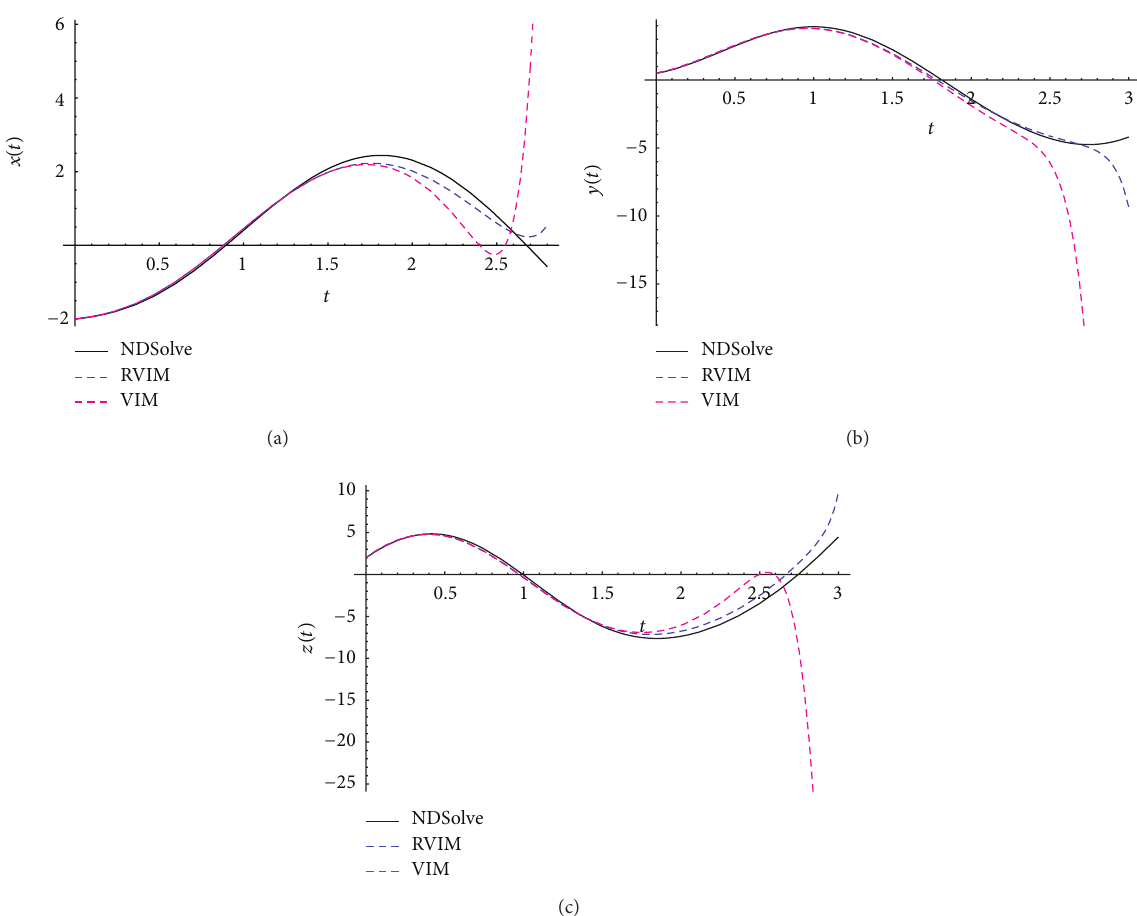
Figure 4: Simulation of the approximate results for 𝛼 1 = 𝛼 2 = 𝛼 3 = .98 and exact results for 𝛼 1 = 𝛼 2 = 𝛼 3 = 1 of the Genesio-Tesi system for parameters 𝛽 1 = 6.5 , 𝛽 2 = 2.92 , 𝛽 3 = 1.2 , and 𝛽 4 = 1.0